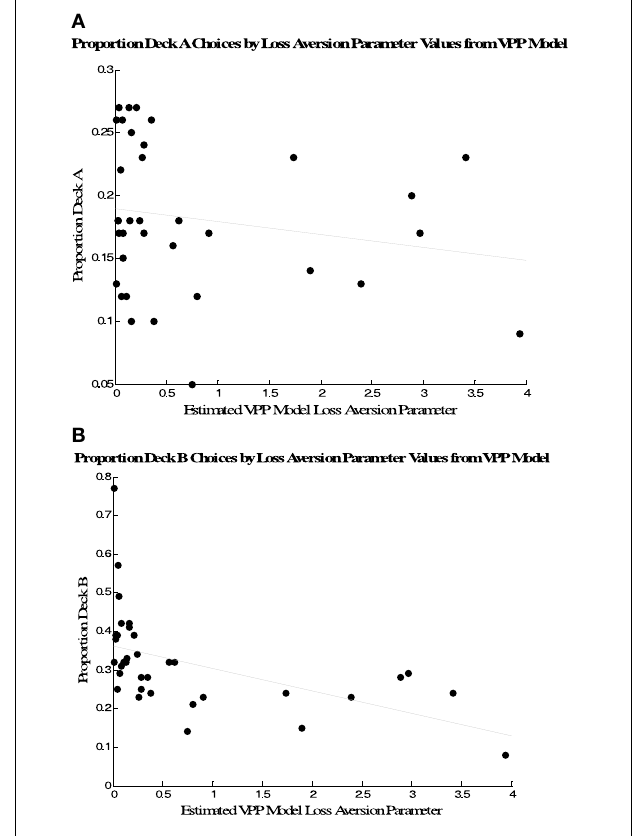
FIGURE 5 | Association between Deck A selections (A) and Deck B selections (B) and individual posterior modes of loss aversion parameter distributions from the VPP